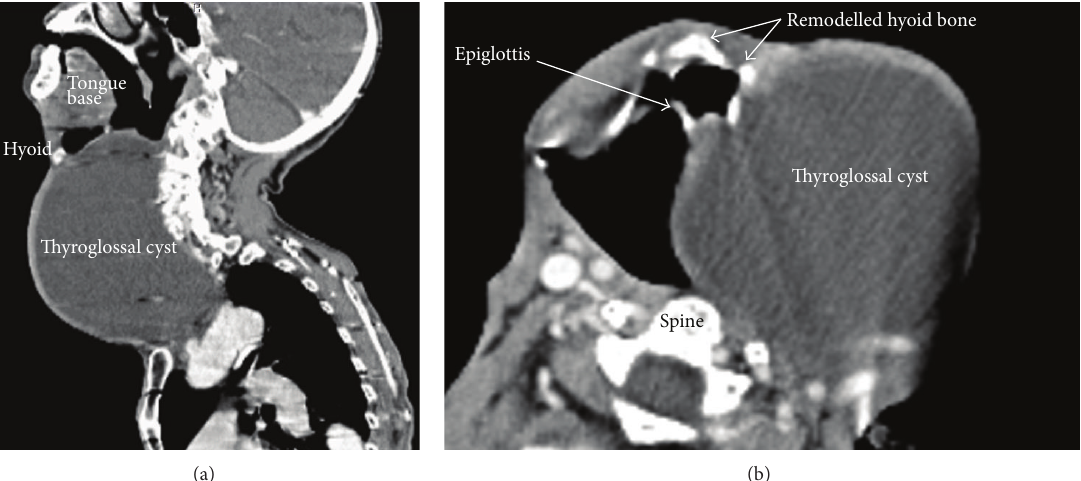
Figure 2: (a) C. T. scan sagittal section showing the relationship of the cyst with hyoid bone and airway. (b) C. T. scan axial section showing the remodelling of hyoid bone in relation to the